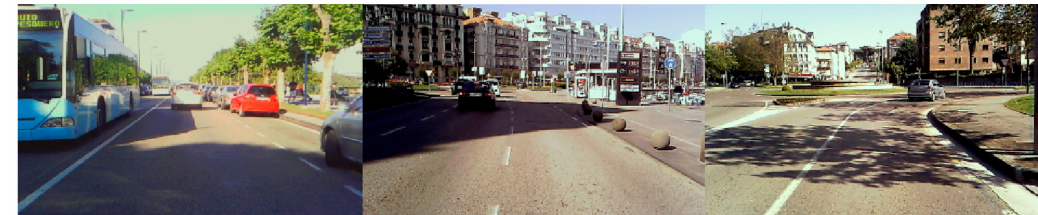
Figure 1. The presence of shadows entails a di ffi cult challenge in vision-based road detection